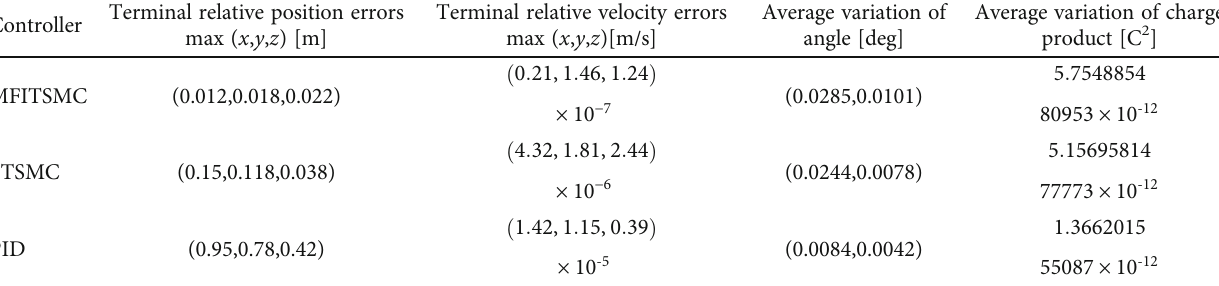
Table 3: The control performance of control algorithms (take follower 1 as an